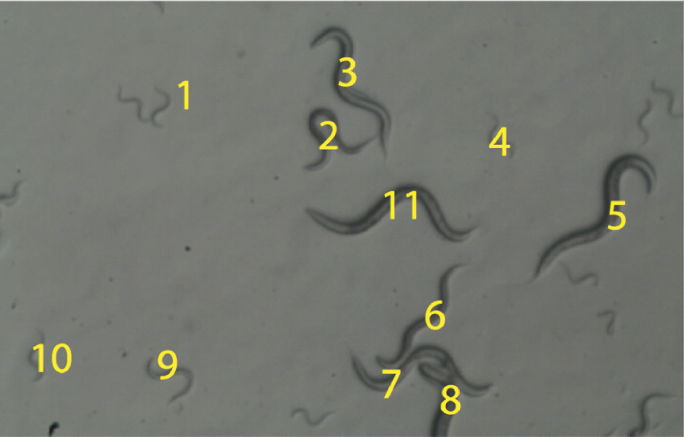
Fig 2. Sample still image of the sample of worms used for scoring by the raters. Each rater was assigned the same sample of worms to score for developmental stage. The worms were shown in both a 40X magnification image (illustrated) as well as a short video recording of each animal. Each worm was identified by a number to facilitate each rater evaluating identical animals in the same order.